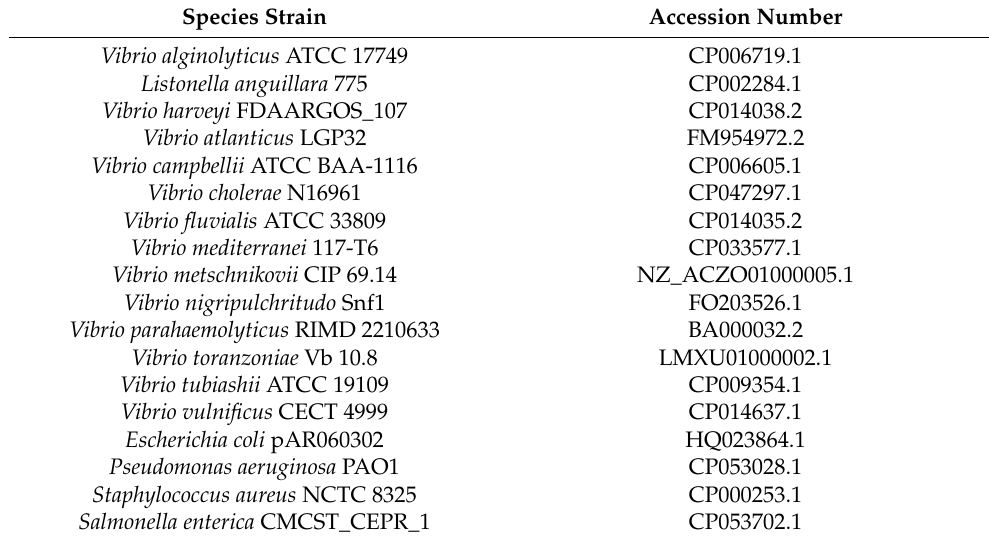
Table 1. Species and accession numbers from NCBI used to design the primers for the groEL